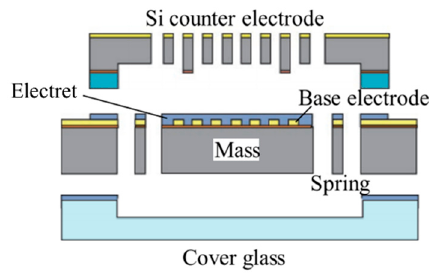
Figure 1. A schematic model of the vibration energy harvester [22].